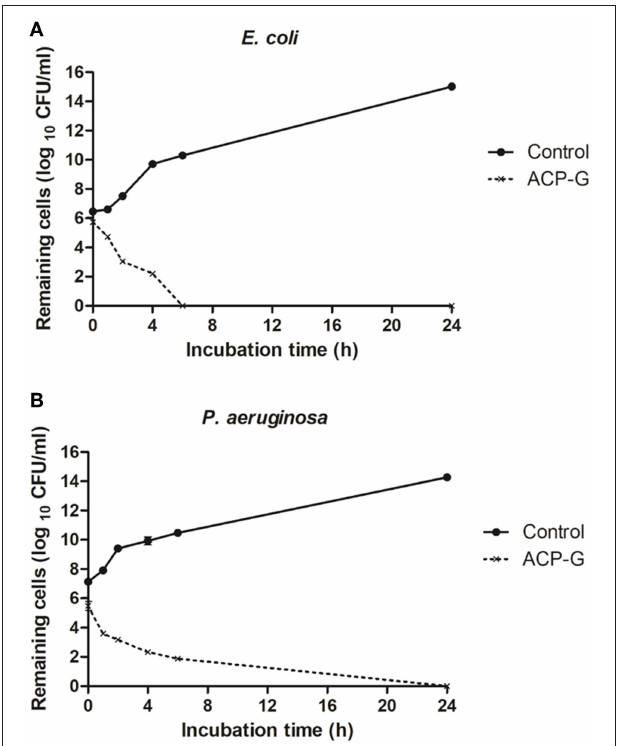
FIGURE 7 | Growth of planktonic cells of: (A) E. coli and (B) P. aeruginosa in presence of plasma-treated steel coupons (Control) and steel coupons plasma coated with gentamicin (ACP-G) submerged in MHB.